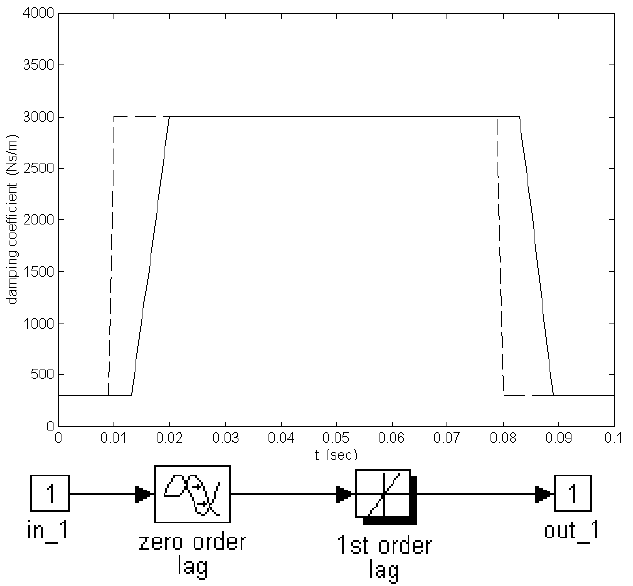
Figure 3. Time delay effect of variable damper (solid: with time delay, dashed: without time delay).